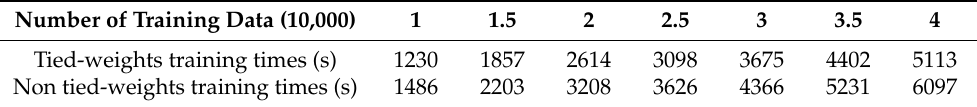
Figure 6. Comparison of tied-weights and non-tied-weights processing results. ( a ) Training time comparison with respect to the training number. ( b ) Denoising result comparison with respect to the training number. ( c ) Denoising result comparison with respect to epochs. The red line represents the tied-weights AE model, and the grey line represents the non-tied-weights AE model. Table 2. Training time comparison with respect to training number of tied weights and non-tied weights.